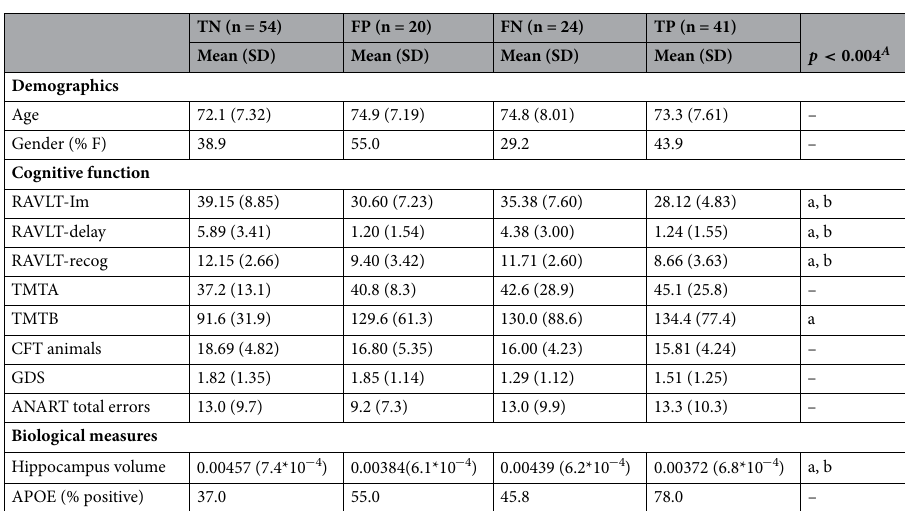
Table 2. Demographics, cognitive function and biological measures in correctly and misclassified patients. TN correctly classified sMCI, FP sMCI subjects misclassified converters, FN cAD subjects misclassified as stable, TP cAD subjects correctly classified, RAVLT Rey Auditory Verbal Learning Test, TMT Trail Making Test, CTF Category Fluency Test, GDS Geriatric Depression Scale, ANART American National Reading Test. Multiple comparisons abbreviated as: a = TN differ from FP; b = FN differ from TP. Group mean differences at Bonferroni corrected alpha level of 0.004 (α altered = 0.05 / 12 = 0.004 , rounded) considered statistically